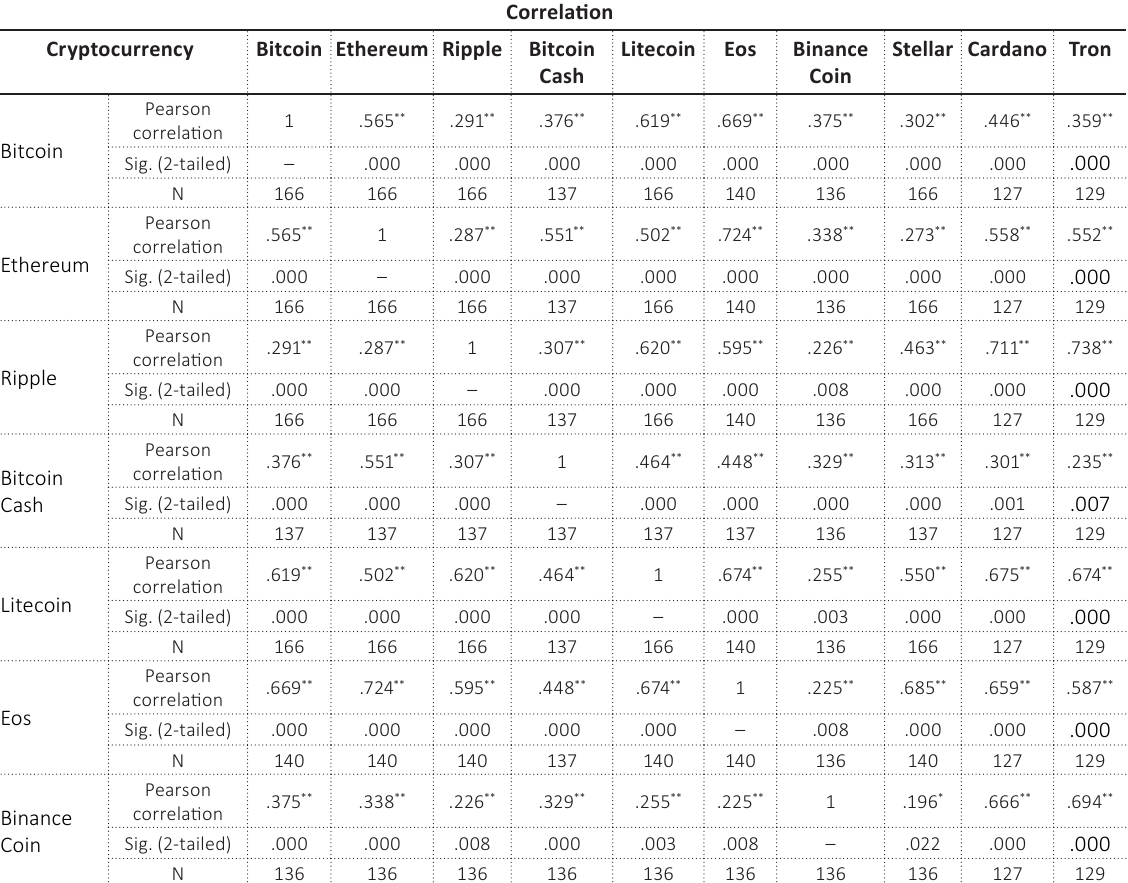
Table 5. Pearson correlation coefficients between cryptocurrency pairs for the entire period (weekly return)